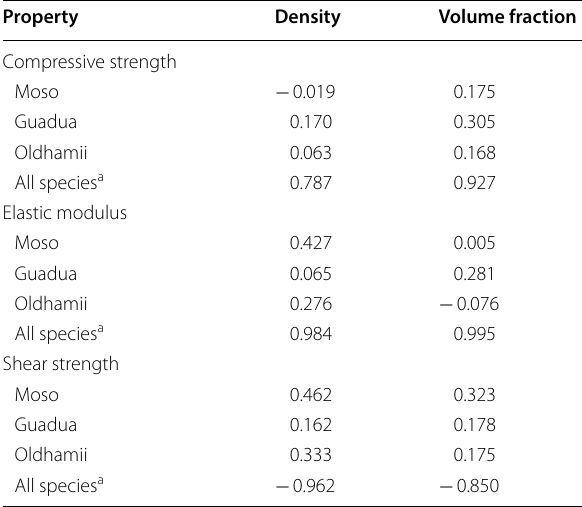
Table 4 Pearson correlation coefficients